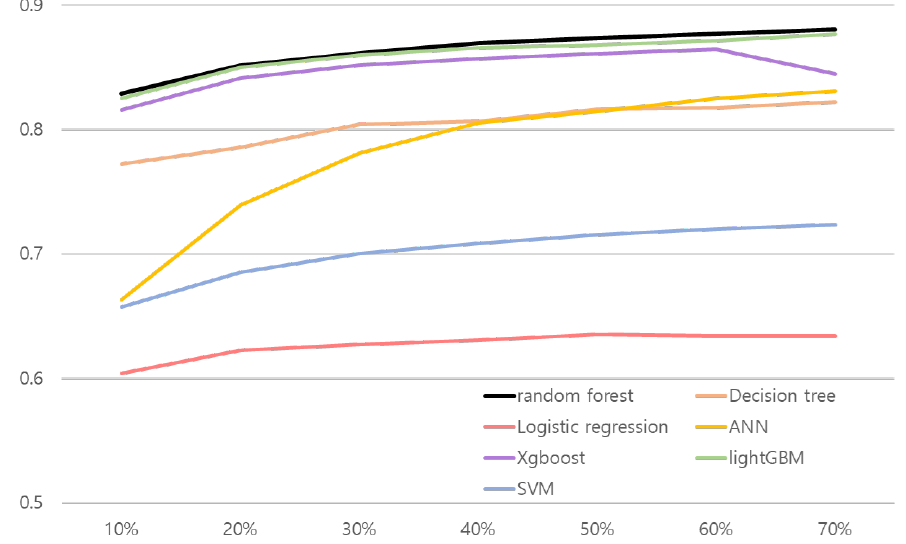
Figure 2. Line plot of hepatitis B risk association model’s performance according to the number of train dataset. x and y axes represent the proportion of training data and AUC, respectively.